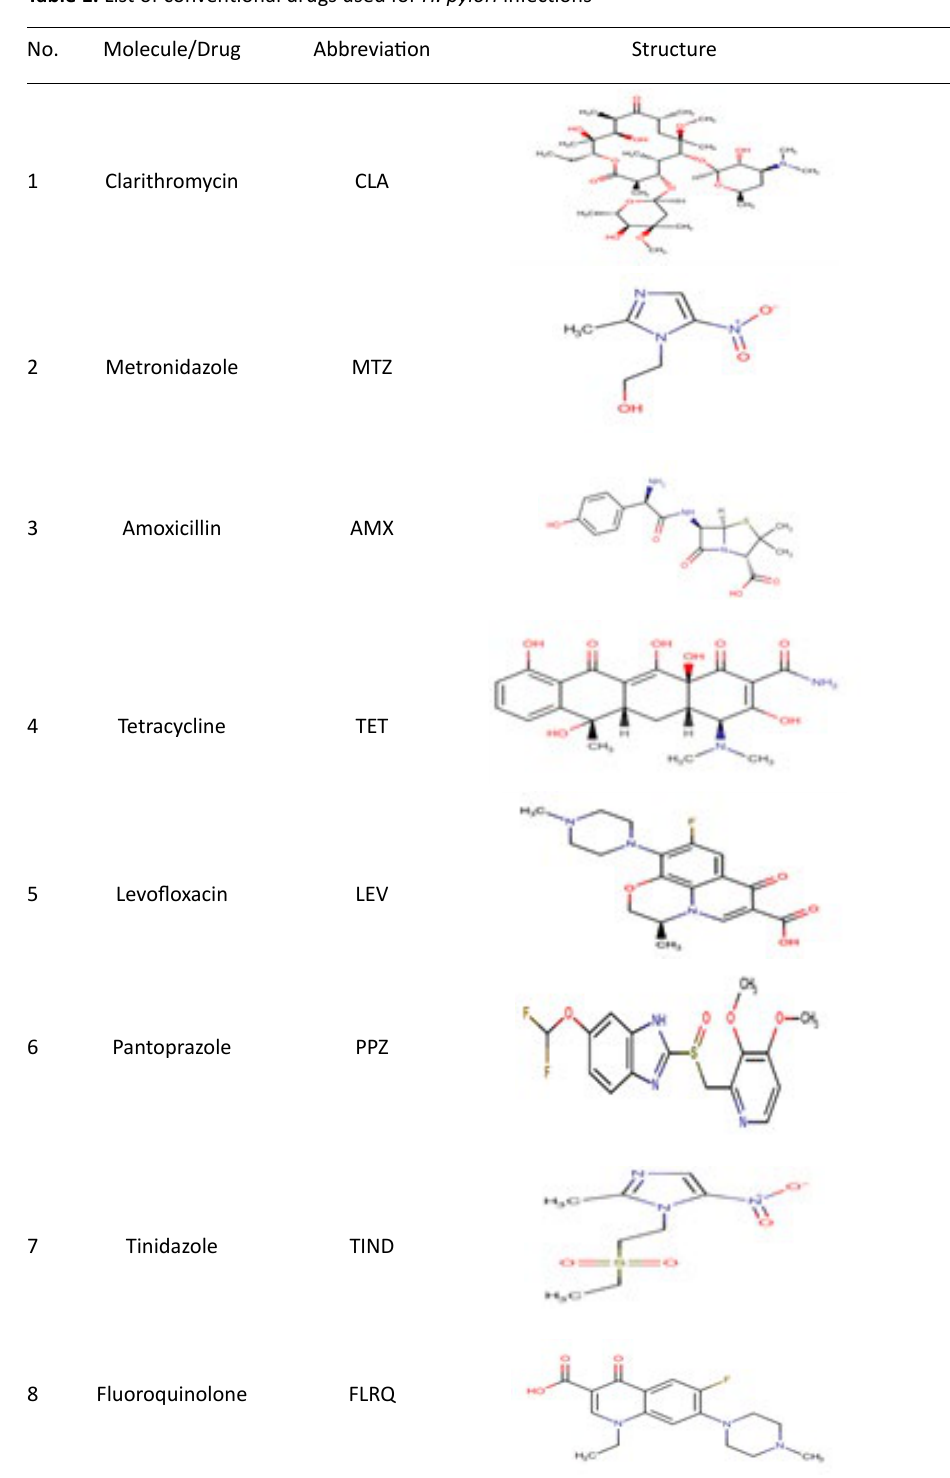
Table 1. List of conventional drugs used for H. pylori infections No. Molecule/Drug Abbreviation Structure